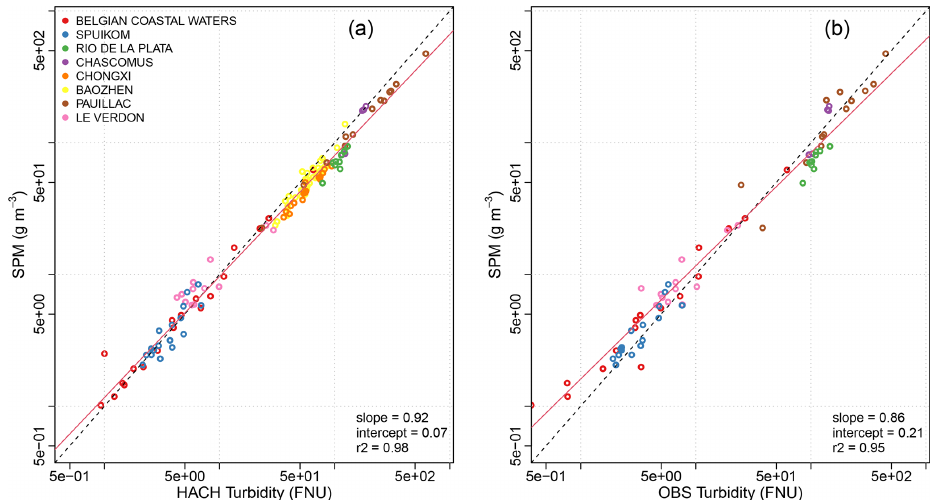
Figure 3. SPM as a function of turbidity. Turbidity from OBS is given by the side-scattering measurement. The dotted line is the 1 : 1 line and the red line represents the linear regression between SPM and turbidity.